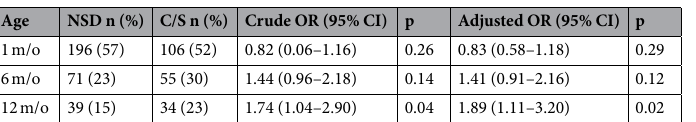
Table 4. Effect of mode of delivery on bacterial colonization of the airway at different age point Number of samples at 1 month of age (1 m/o): 546 (NSD: 343, C/S: 203). Number of samples at 6 month of age (6 m/o): 490 (NSD: 308, C/S: 182). Number of samples at 12 month of age (12 m/o): 408 (NSD: 262, C/S: 146). Adjusted for gestational age, sex, birth body weight, maternal education, smoking during pregnancy, and parental